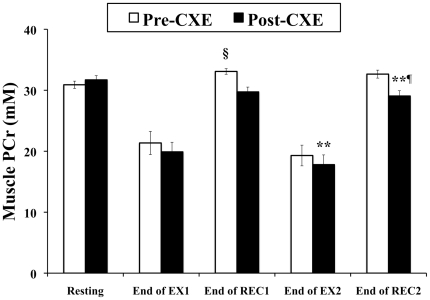
The effect of altitude exposure on phosphocreatine ‘overshoot’ in skeletal muscle.Values are means over the last minute of each period. CXE  =  Caudwell Xtreme Everest expedition, EXx  =  exercise bout x, RECx  =  recovery period after exercise bout x. ** different from pre-CXE at p<0.01; §End-REC1 PCr is different from resting PCr pre-CXE at p<0.05; ¶End-REC2 PCr is different from resting PCr post-CXE at p<0.05.